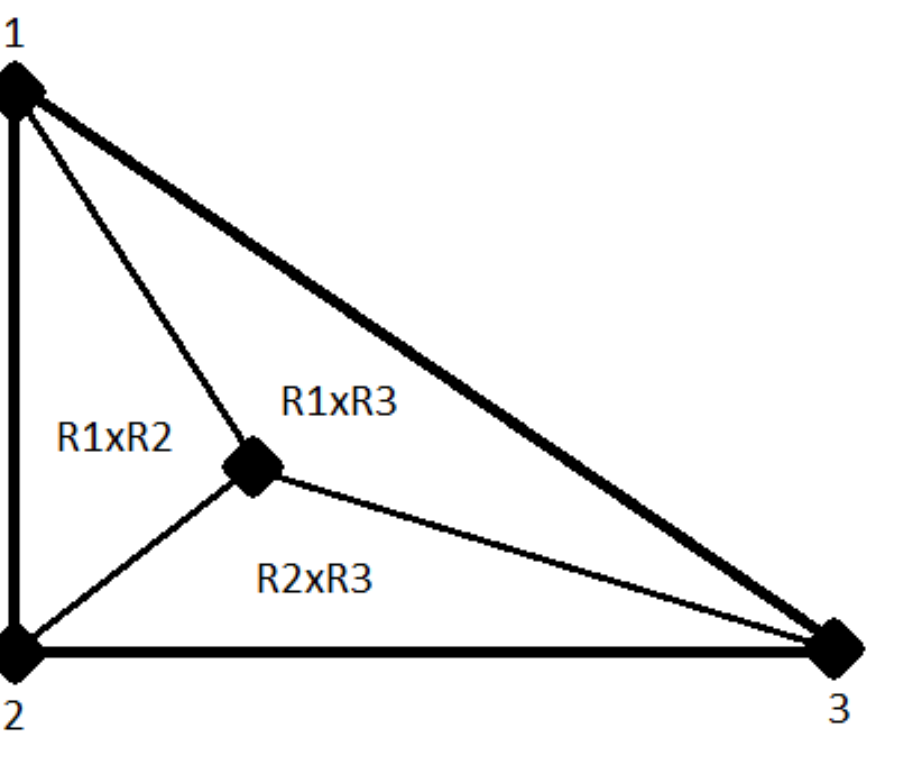
Figure 1. Triangle element face divided into three parts.